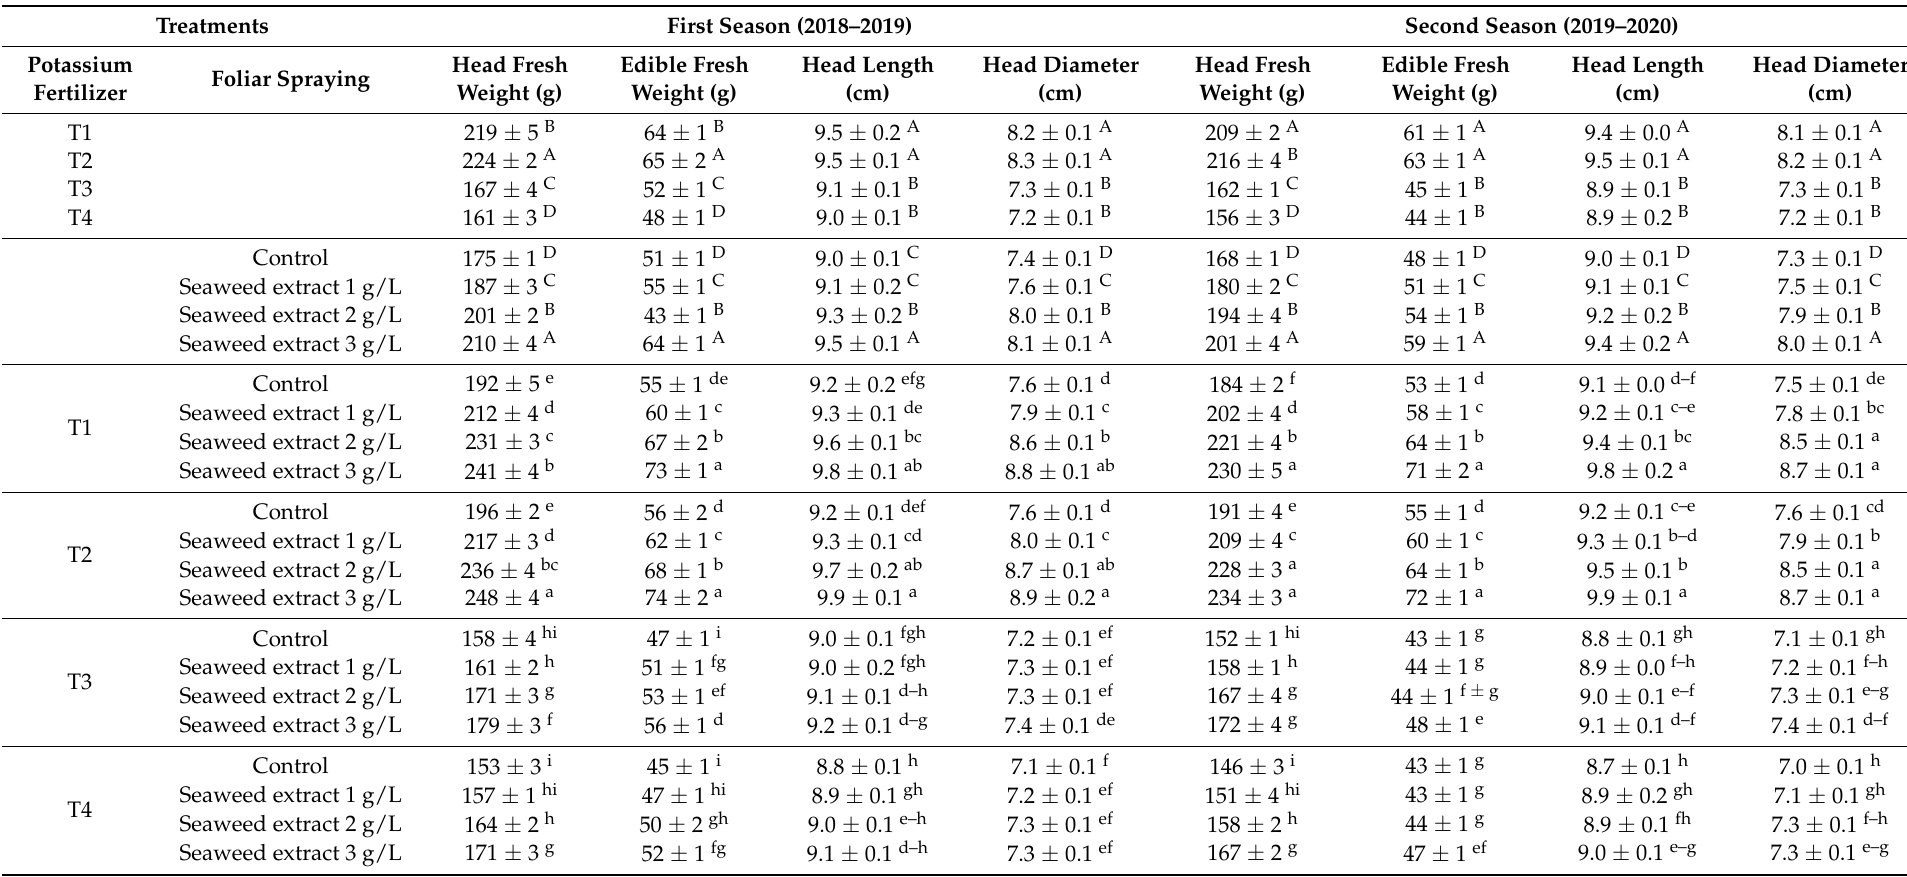
Table 7. The effect of potassium fertilizer, biofertilizer, and foliar spraying of seaweed extract on head quality of globe artichoke.